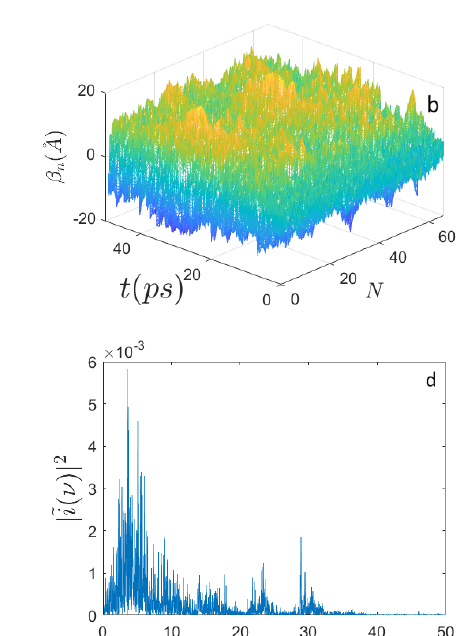
Figure 5. Time evolution of ( a ) the electron probability amplitude | Ψ ( t ) | 2 ; ( b ) the average displace- ments β n ( ˚ A ) ; ( c ) the electron current i ( t ) (expressed in µ biot); ( d ) the frequency spectrum | ˜ i ( ν ) | 2 along the sequence of N = 66 nucleotides with the initial conditions E 0 = 0.2 eV ( E (cid:48) = 30) and the initial electron excitation peaked around the site n 0 = N /3. The other parameters are the same of Figure 1.